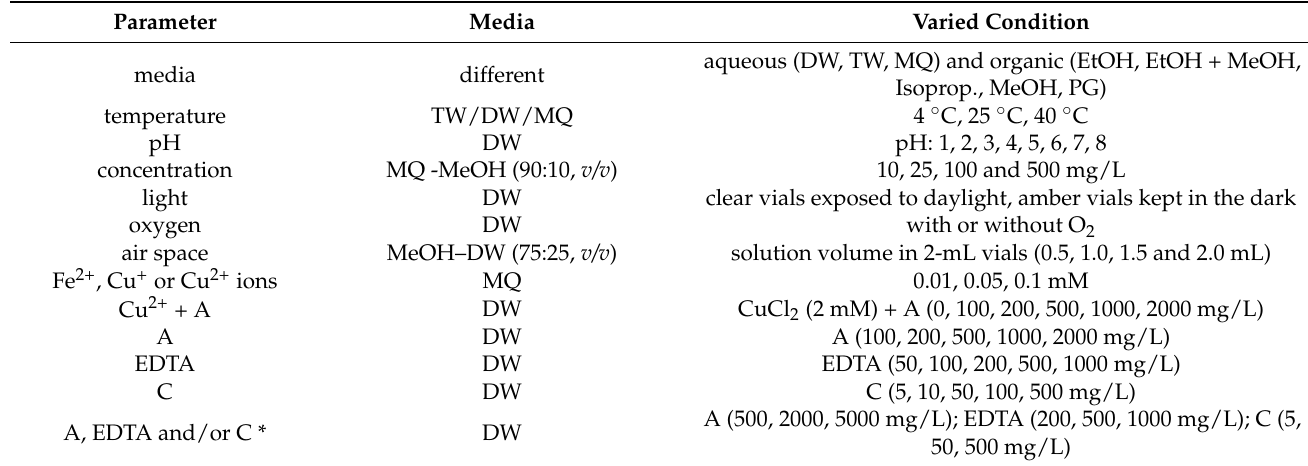
Table 1. Selected parameters along with tested conditions within the vitamin D3 stability study in aqueous solutions (vitamin D3 concentration = 20 mg/L unless otherwise